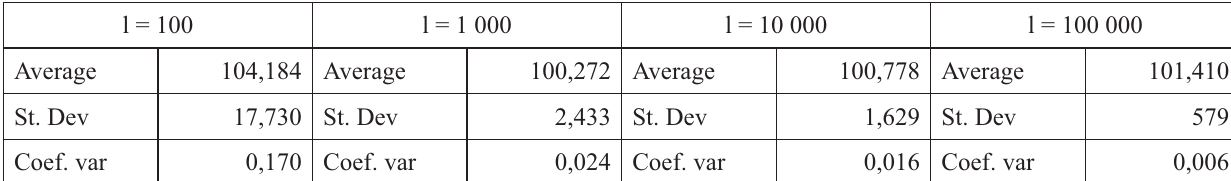
Fig 2. Simulated profi t/loss values of the portfolio (“dvp” Table 1. VaR statistics with different notions of “l” variable